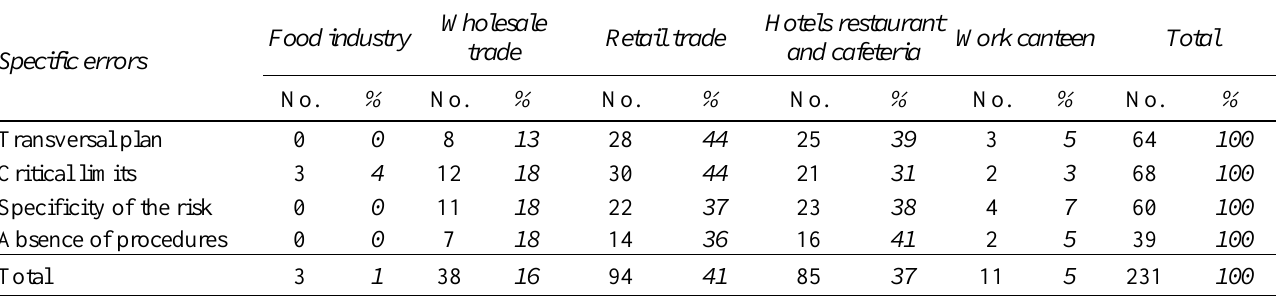
Table 6: Distribution of the general errors, for class of activity of the food